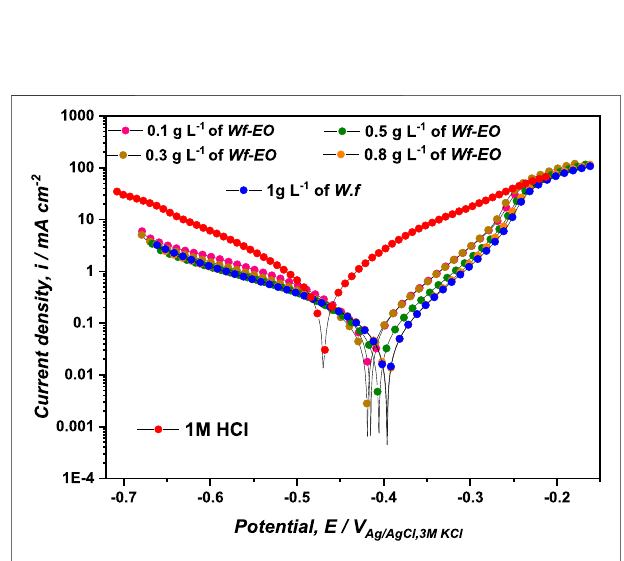
FIGURE 4 | Polarization curves of MS in 1.0 M HCl at different concentrations of Wf-EO at 298 K.